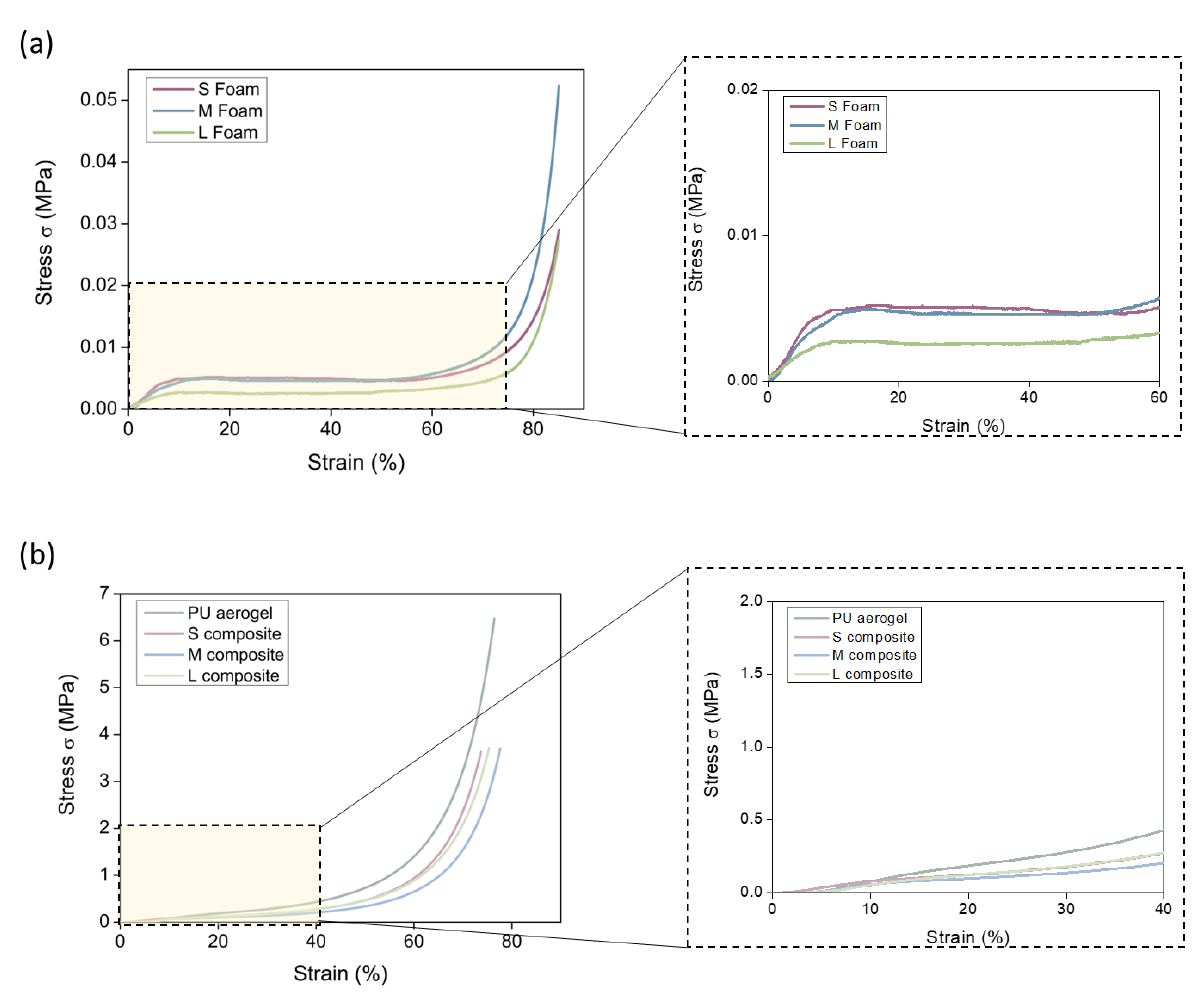
Figure 8. ( a ) Strain – stress curves for the polyurethane foams, ( b ) composites at deformations of 80%.